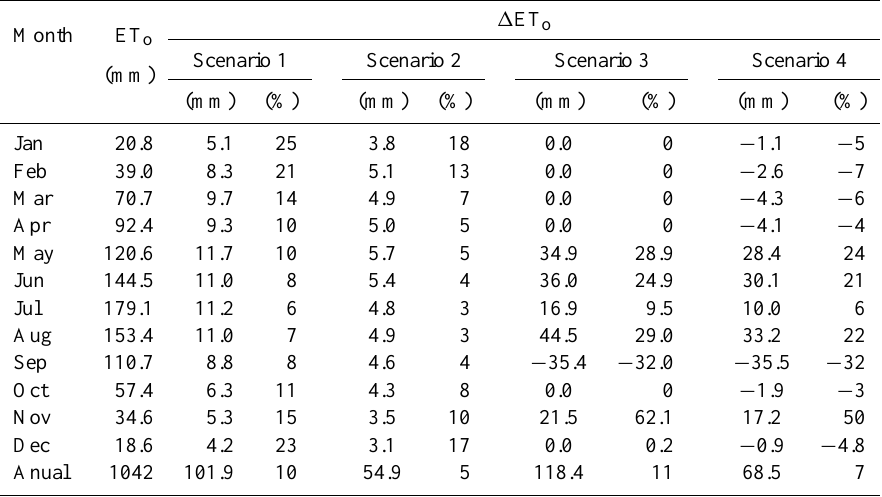
Table 3. Mean monthly reference evapotranspiration (ET o , mm) and increments ( 1 ET o ) of the four scenarios according to Table 2. Data are based on 38 stations using the reference year of